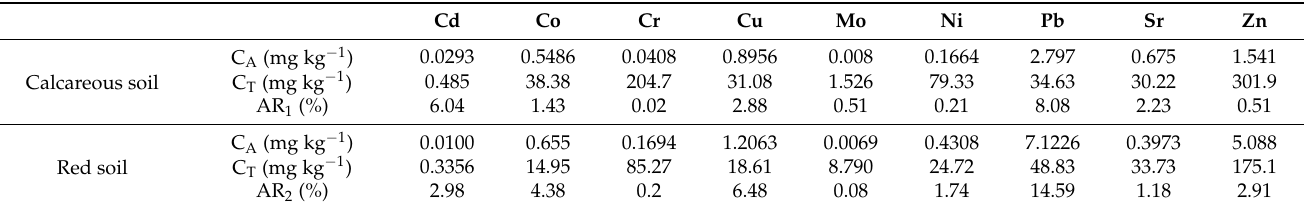
Table 3. The available (C A ) and total contents (C T ),activation rate (AR) of heavy metals in the surface soil, risk screening values (RSV) for agricultural soil contamination, and the national food quality standard